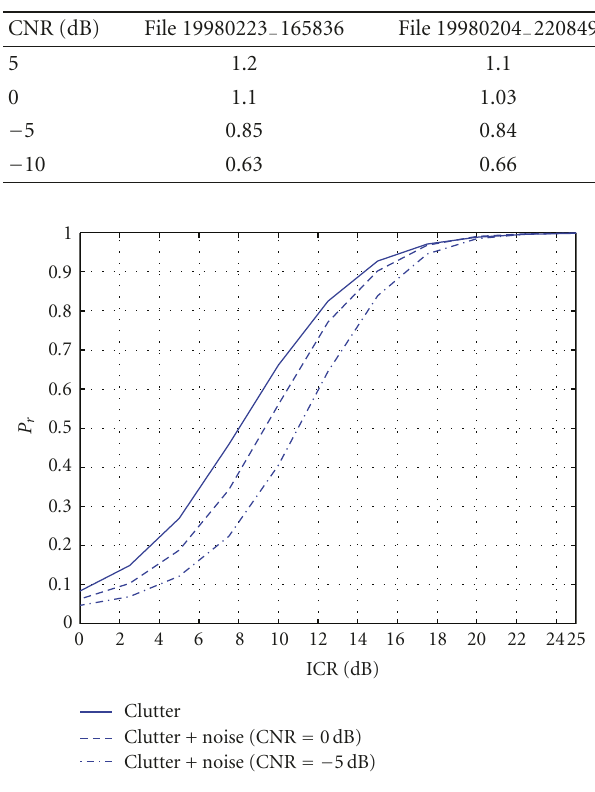
Figure 15: P r versus INR. Data from file 19980204 − 220849 in the presence of thermal noise, with N = 8, K = 24, N it = 1, and P e 0 .